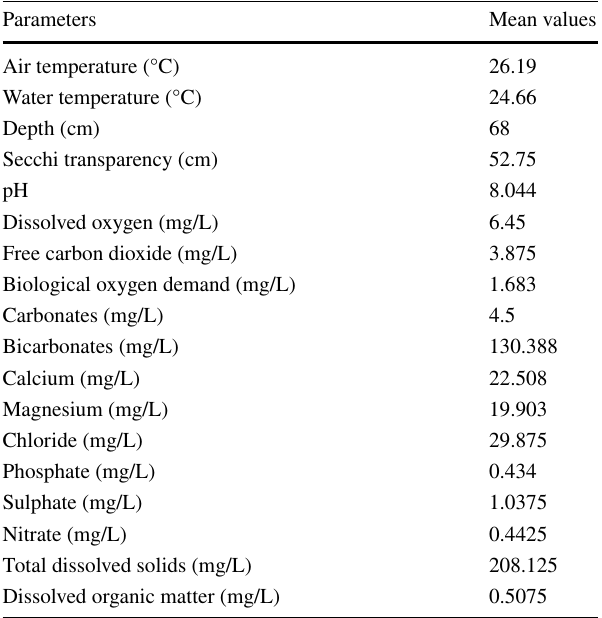
Table 1 Mean values of physical and chemical parameters of water of Lake Mansar during the study period (Summer 2015–Spring 2017)